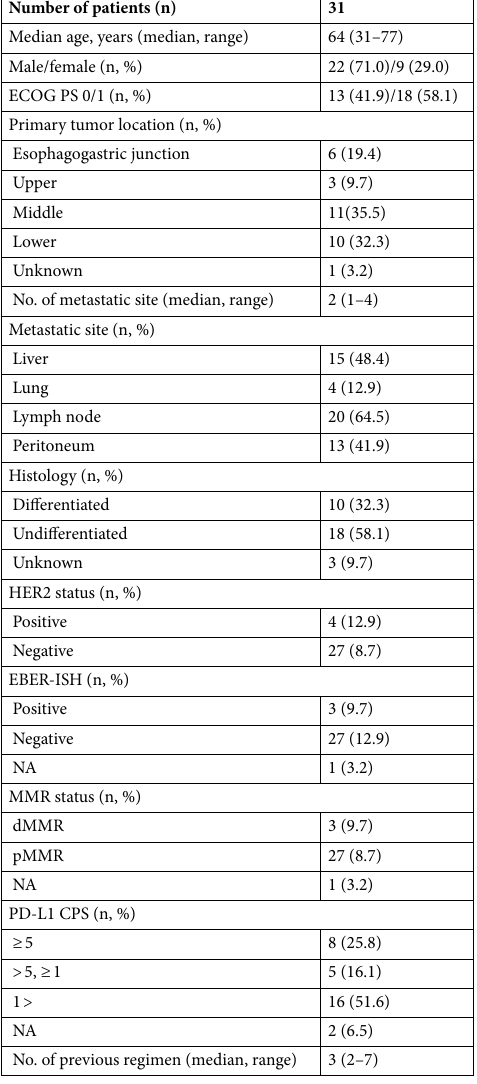
Table 1. Baseline characteristics. dMMR mismatch repair-deficient, EBER-ISH Epstein–Barr virus (EBV)- encoded RNA in-situ hybridization, ECOG PS Eastern Cooperative Oncology Group performance status, HER2 human epidermal growth factor receptor 2, MMR mismatch repair, NA not available, PD-L1 CPS programmed death ligand 1 combined positive score, pMMR mismatch